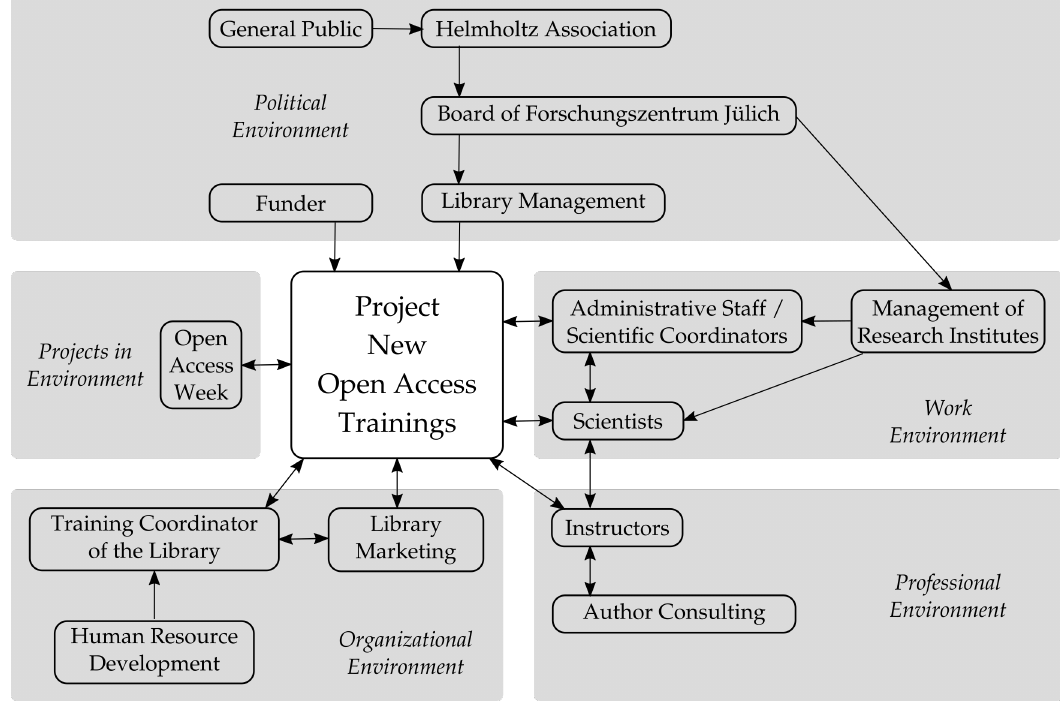
Figure 1. The stakeholder analysis of the project, which divides the stakeholders into five areas: political environment, work environment, professional environment, organizational environment and projects in the environment. The importance of stakeholders is reflected by their proximity to the project in the center.